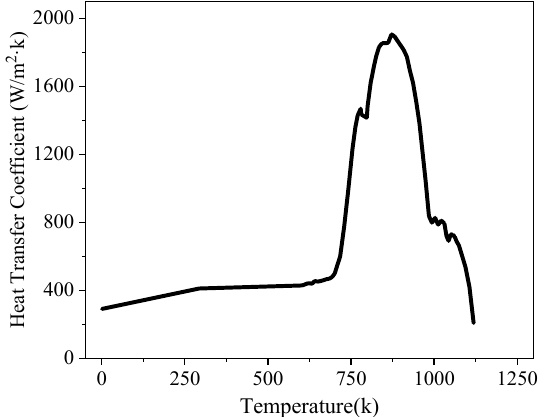
Figure 3. Heat transfer coefficient curve.